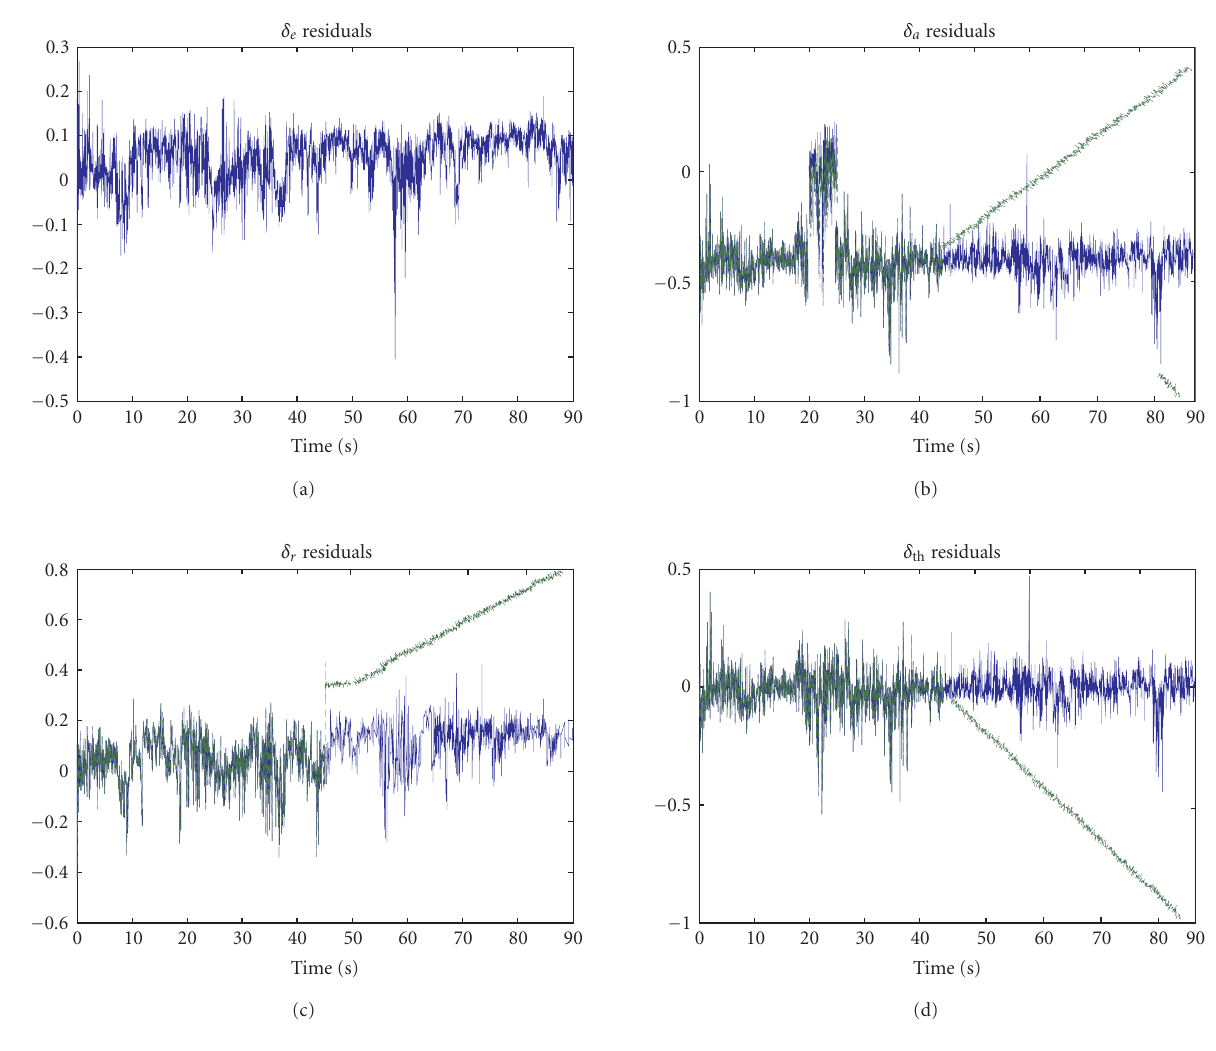
Figure 4: NN residuals with ramp